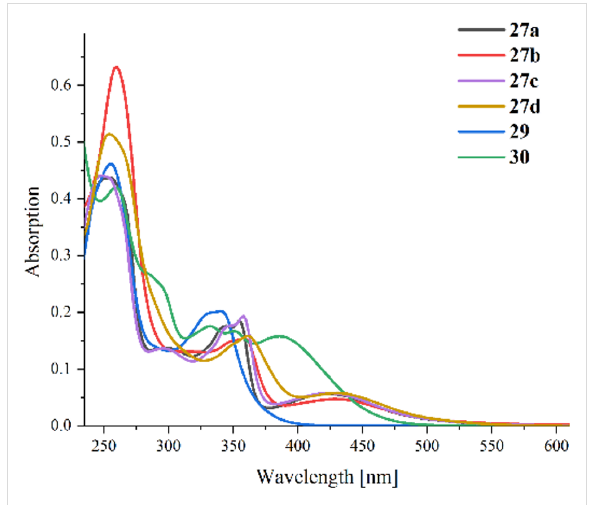
Figure 1: UV–vis absorption spectra of the obtained metal complexes (18 µM solutions) in acetonitrile at 20